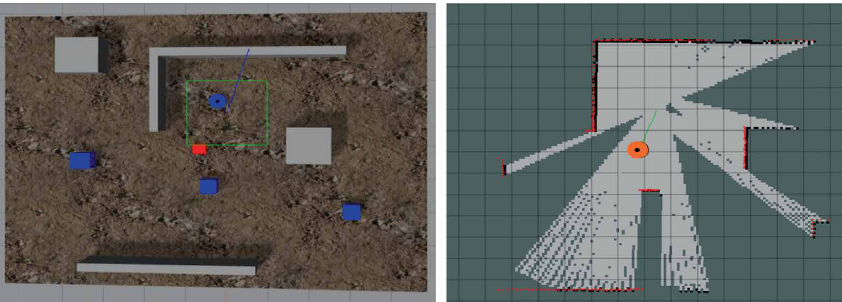
Figure 7: Local exploration process.